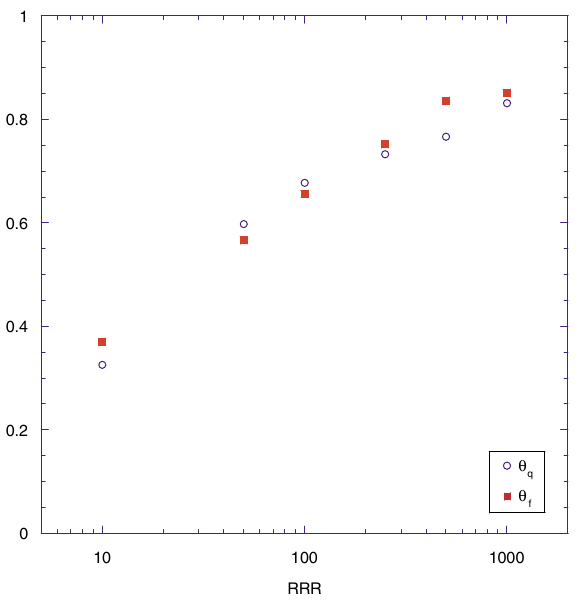
FIG. 10. (Color) Relative performance of a 700 MHz cavity as a function of the Nb